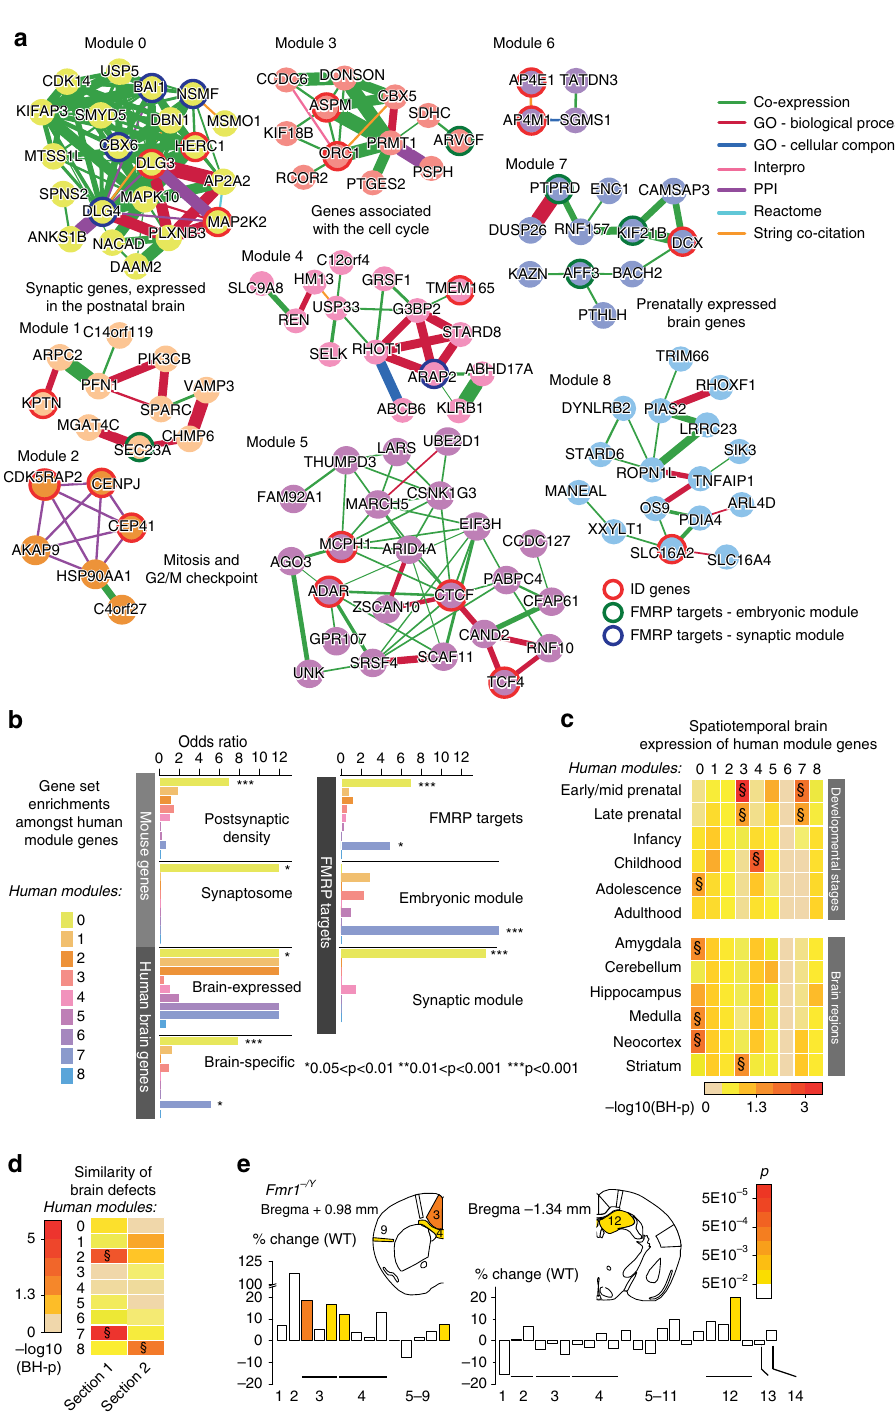
Fig. 5 Functional characterization of human gene modules. a The PLN (Phenotypic Linkage Network) identi fi es 381 functional links between 121 human orthologs of NeuroAnatomical Phenotype (NAP) genes, which partitioned into the 9 modules of closely related genes (illustrated by the color of the nodes). The thickness of each edge is proportional to the functional similarity score, as given by the PLN, and the color of each edge indicates the largest contributing information source. Red borders depict known ID-associated genes, whereas blue and green borders refer to the set of embryonically expressed and mature Fragile X Mental Retardation Protein (FMRP) target genes, respectively. Module descriptions were added, where clearly discernable. b Gene set enrichment analysis across the nine human modules. c Spatiotemporal expression dynamics of module genes compared to the remaining NAP orthologs. d The heat map depicts the similarity of brain abnormalities caused by module genes in the critical sections 1 and 2 (Bregma + 0.98 mm and − 1.34 mm, respectively). The color code corresponds to the adjusted p value with double S (§) referring to BH-p < 0.05 ( c , d ; permutation test). e New neuroanatomical study of Fmr1 − /Y in the coronal plane ( n = 4 wild types (WTs) and n = 6 Fmr1 − /Y , male). Top: Schematic representation of the affected brain parameters at Bregma + 0.98 mm and − 1.34 mm. Numbers refer to the same brain parameters from Fig. 2b and Supplementary Fig. 2b, c. The color code indicates the unadjusted p value. Bottom: Histograms showing the percentage of increase/decrease of the brain parameters compared to